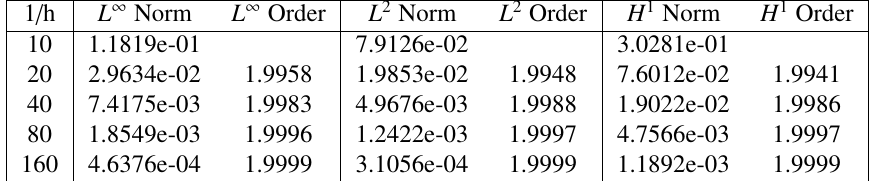
Table 9. Errors and Convergence Rate for Quadratic IFEM-CN Approximation for Example